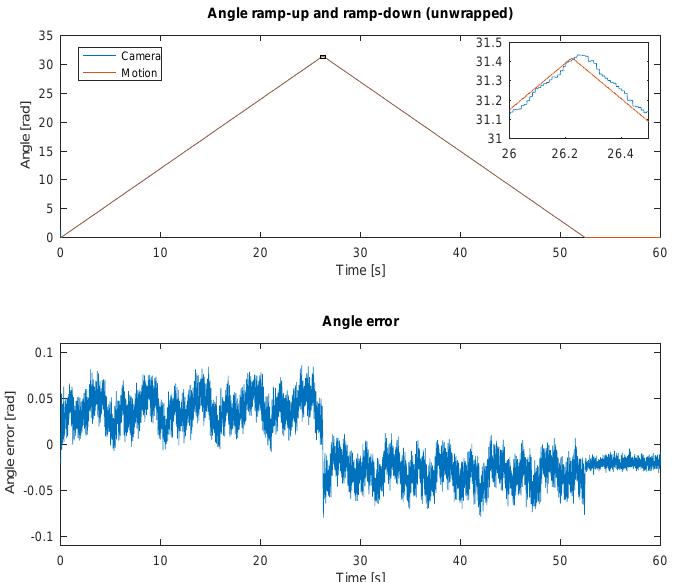
Figure 14. Experiment 2—tracking angular position of the object by observing it rotating 5 revolutions in one direction and 5 revolutions back to initial position ( top ) with resulting angular error ( bottom